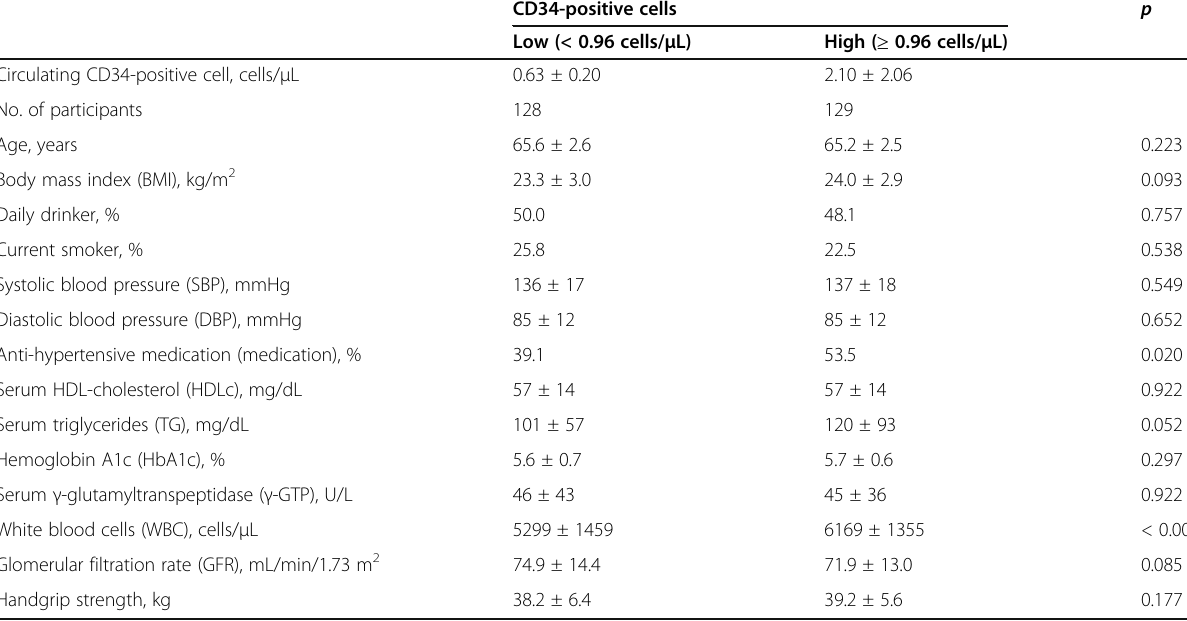
Table 1 Characteristics of the study population by CD34-positive cell levels